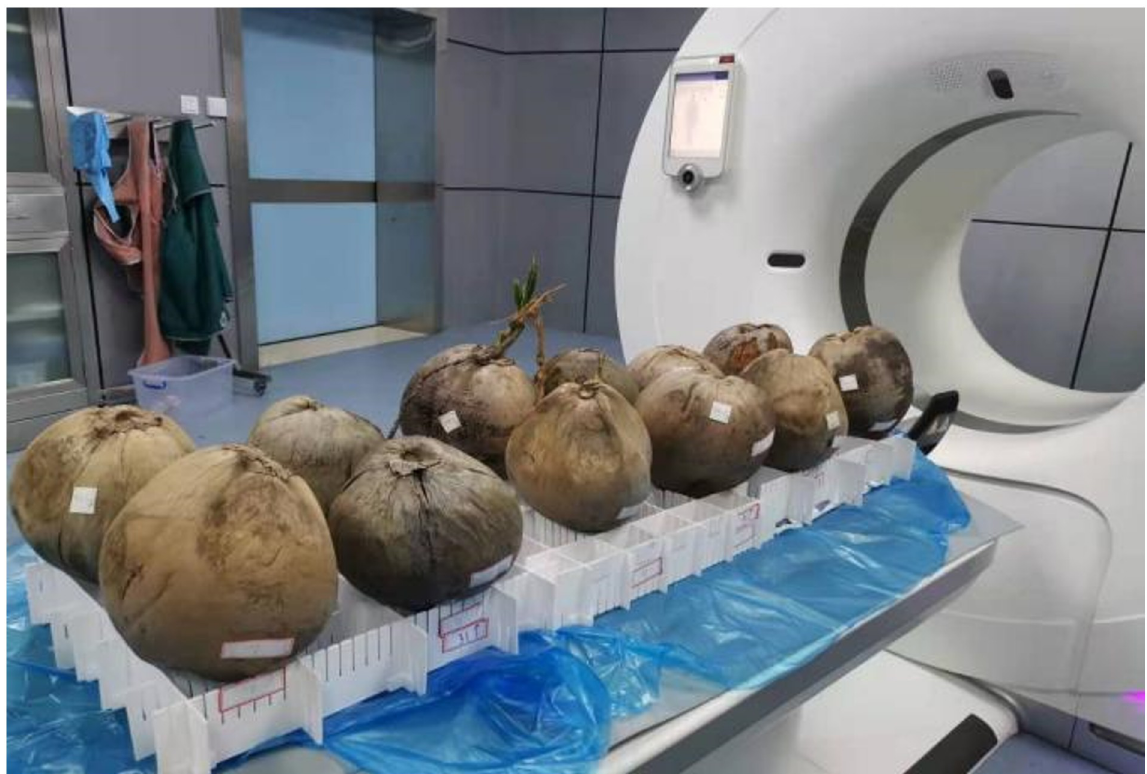
Fig 1. The position of the coconuts on the computed tomography